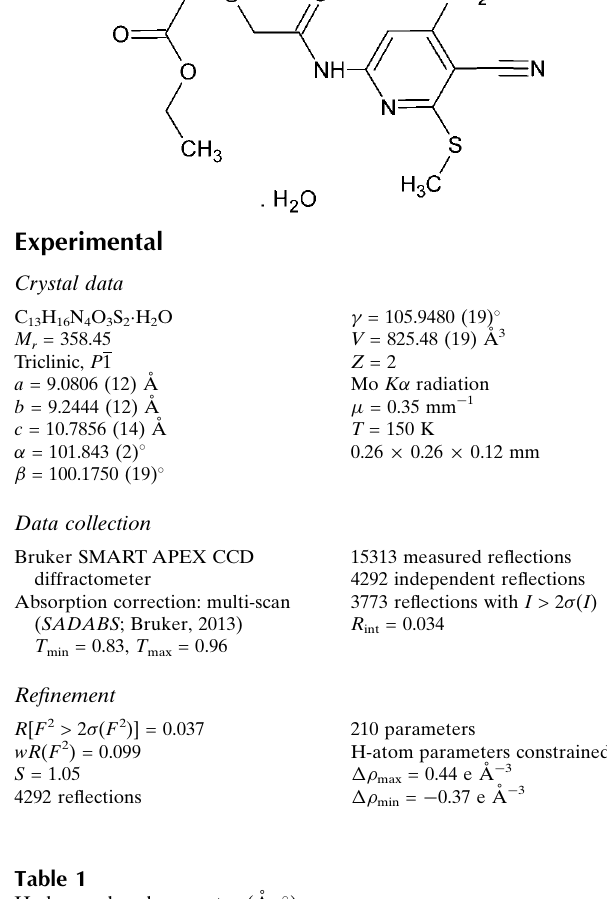
Hydrogen-bond geometry (A˚ , (cid:3) ). D —H (cid:2)(cid:2)(cid:2)